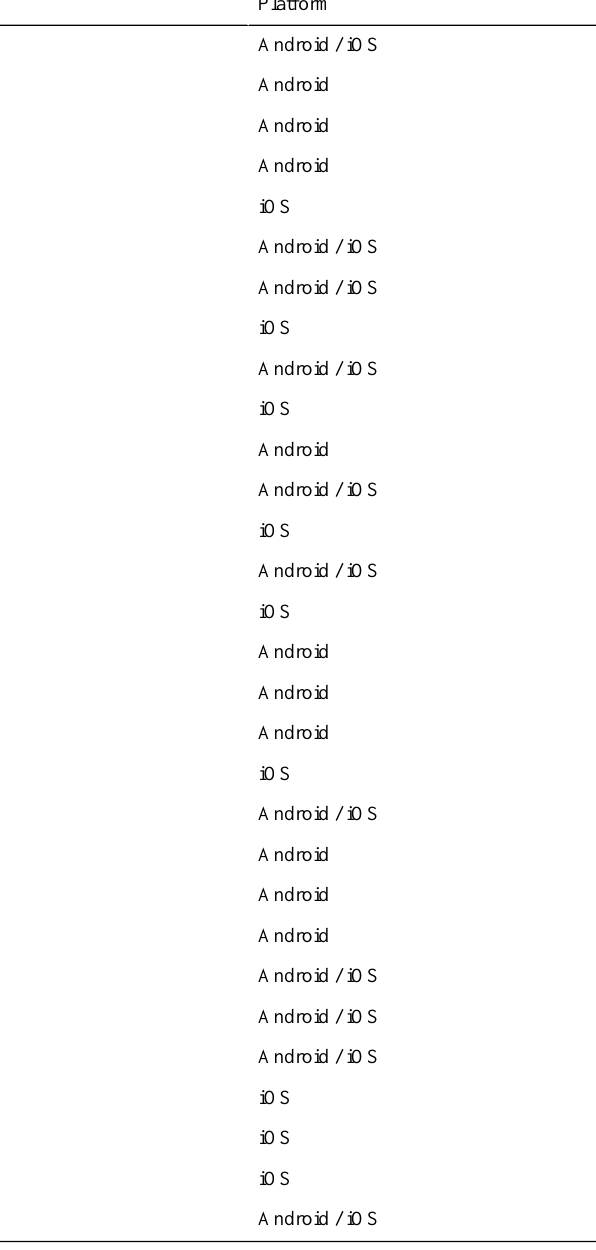
Table 1. List of multiple sclerosis (MS) apps.